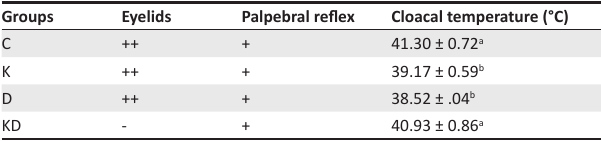
TABLE 2: The status of eyelids, response of palpebral reflex and cloacal temperature in pigeons of different groups. Groups